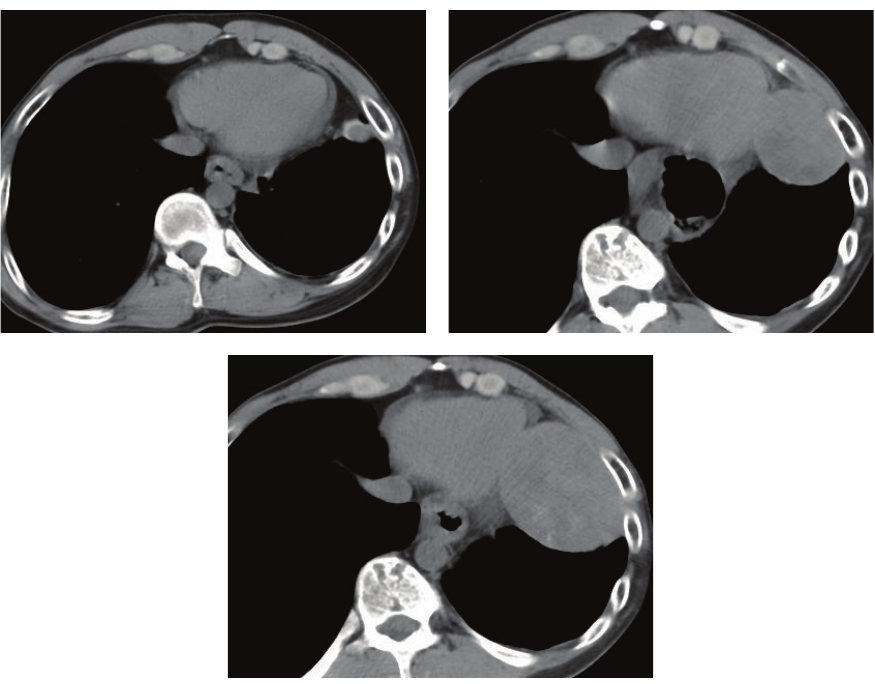
Figure 1: Noncontrast chest CT shows enlarging heterogeneous, well defined mass lesion at the level of left cardiophrenic recess (consecutive CTs from 2006, 2011, and 2013). The patient also had a hiatal hernia characterized by dilation and wall thickening of the distal esophagus. This was treated with Nissen fundoplication in 2012.